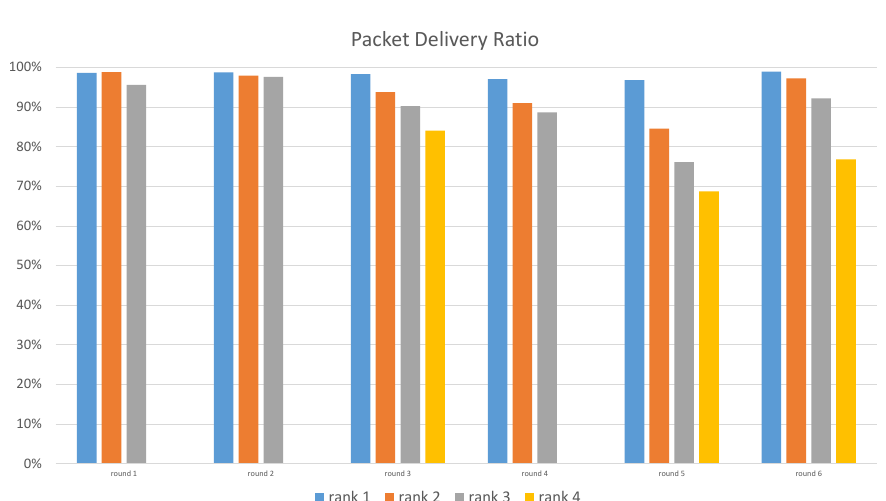
Figure 14. Results comparison of PDR for different packet sizes and sending intervals, grouped by node